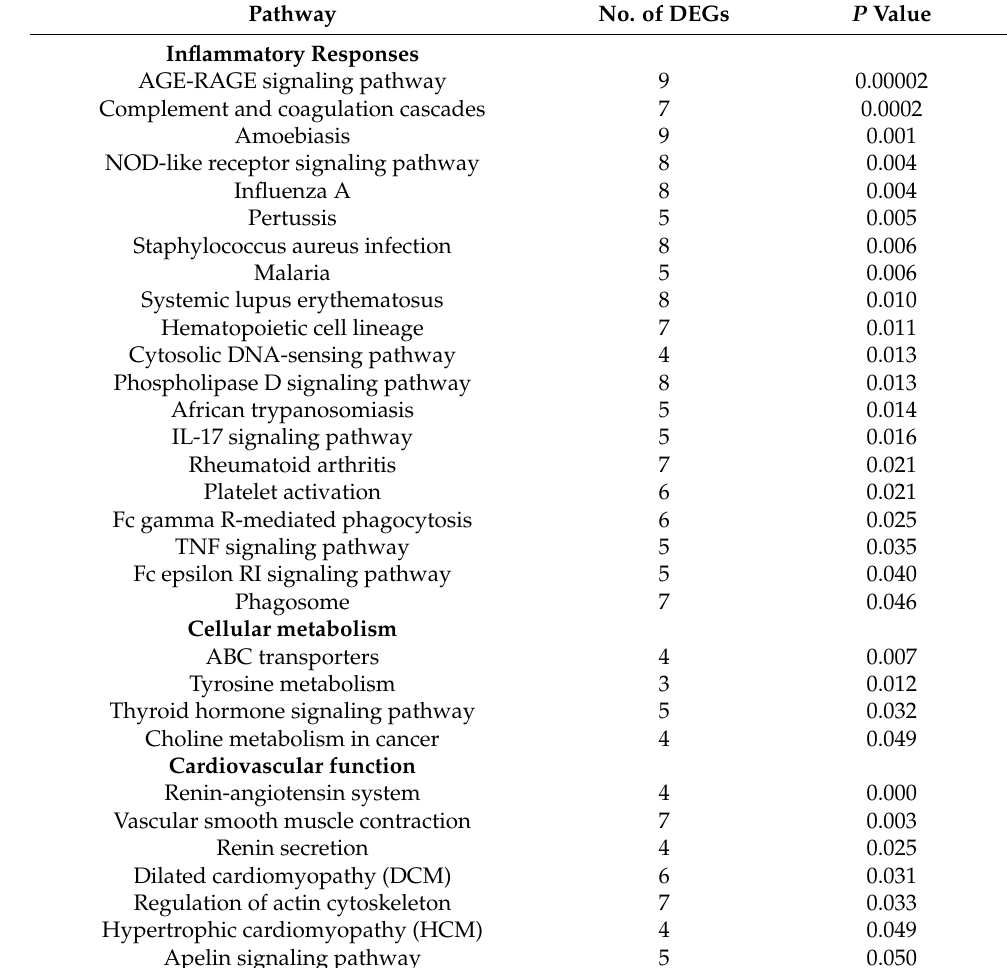
Table A3. KEGG enriched pathway (upregulated DEGs from naïve control vs. FDM).